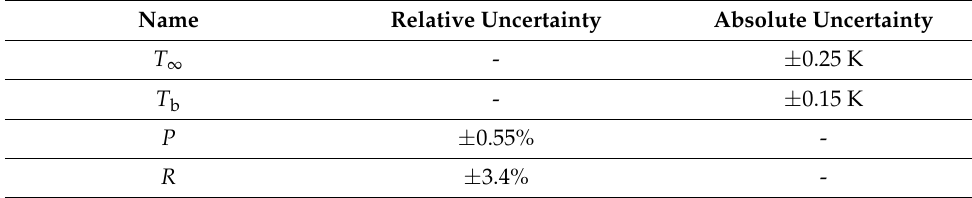
Table 1. Typical uncertainty of measured values.